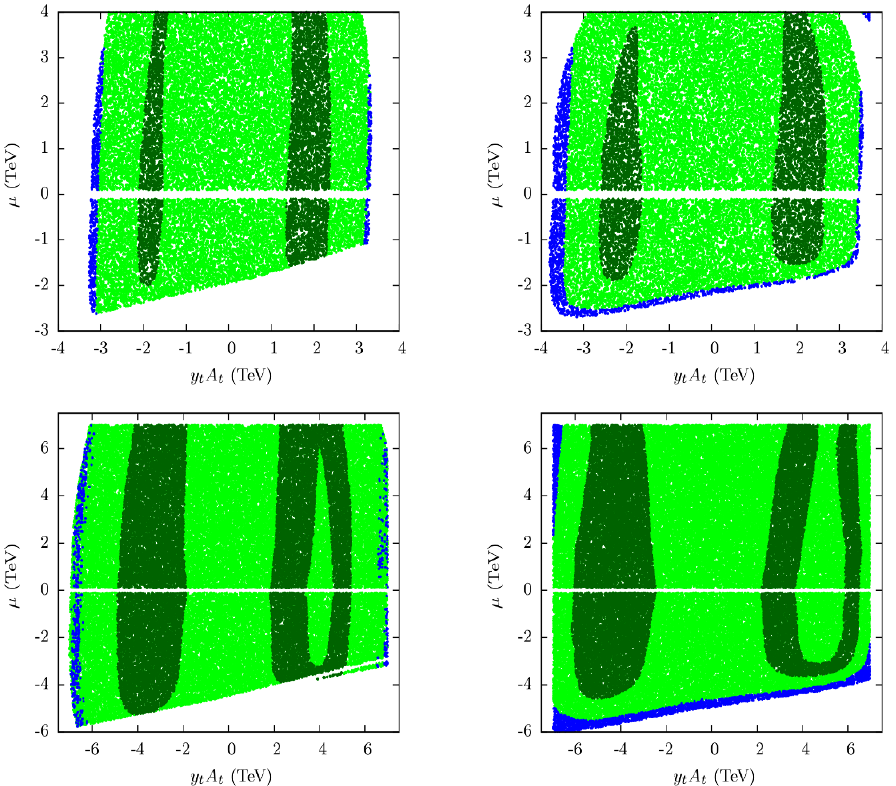
Figure 1 . Scatter plots showing the regions with the DSB vacuum as the global minimum of the potential (green) and with an accompanying non-DSB CC minimum as the global minimum of the same (in blue) in the y t A t - (cid:22) plane. Plots in the left (right) panel are obtained from the SPheno - Vevacious ( FeynHiggs-Mathematica ) framework. The top (bottom) panel corresponds to m = m = m = 1 TeV (2 TeV). Other (cid:12)xed parameters are as follows: M 1 = M 2 = 750 GeV e Q 3 e U 3 e D 3 and M 3 = 2 TeV, m A = 2 TeV, A b = 0 and tan (cid:12) = 25. The renormalization scale is set to p Q = m m . Regions in dark-green are compatible with the observed SM-like Higgs boson e Q 3 e U 3